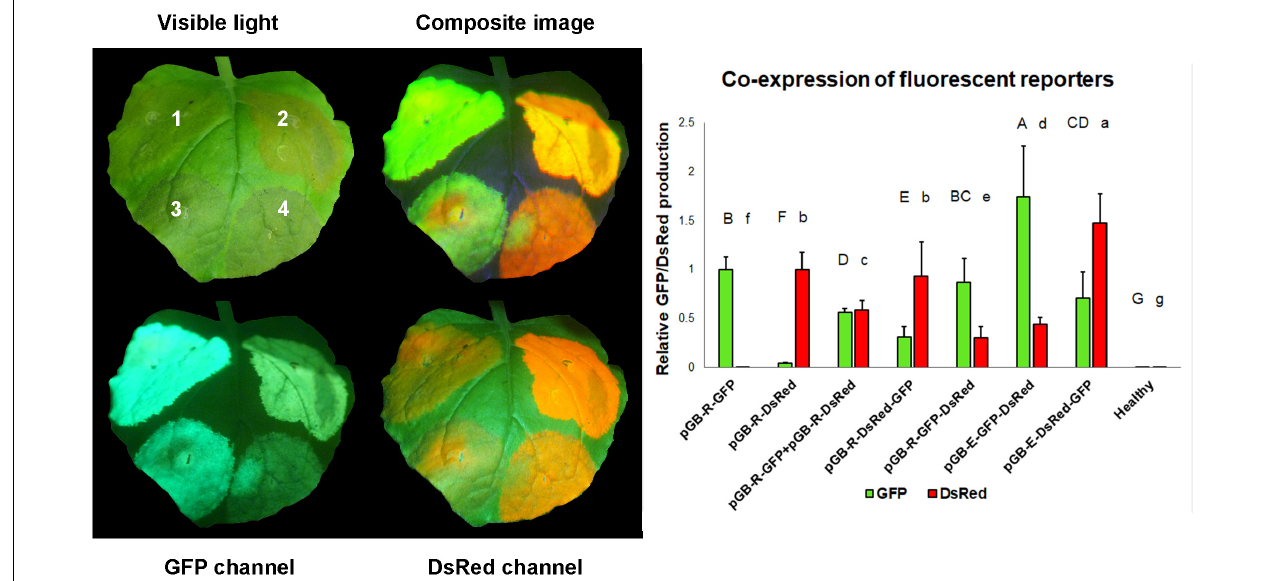
FIGURE 5 | Co-expression of two fluorescent reporter genes. N. benthamiana leaves were infiltrated with replicating and non-replicating constructs expressing GFP and DsRed that were either present on one plasmid or on two co-infiltrated plasmids. Relative expression of fluorescent reporters 5 days after infiltration. Left panel Representative image of leaf infiltrated by EHA105 carrying: (1) pGB-E-GFP-DsRed; (2) pGB-E-DsRed-GFP; (3) pGB-R-GFP-DsRed; (4) pGB-R-DsRed-GFP and visualized under visible light, GFP channel or DsRed channel. Right panel Graphical representation of GFP and DsRed co-expression. The fluorescence obtained with single reporter replicating vectors were used as 1.0. Statistically significant differences at p = 0.05 are marked by different letters.